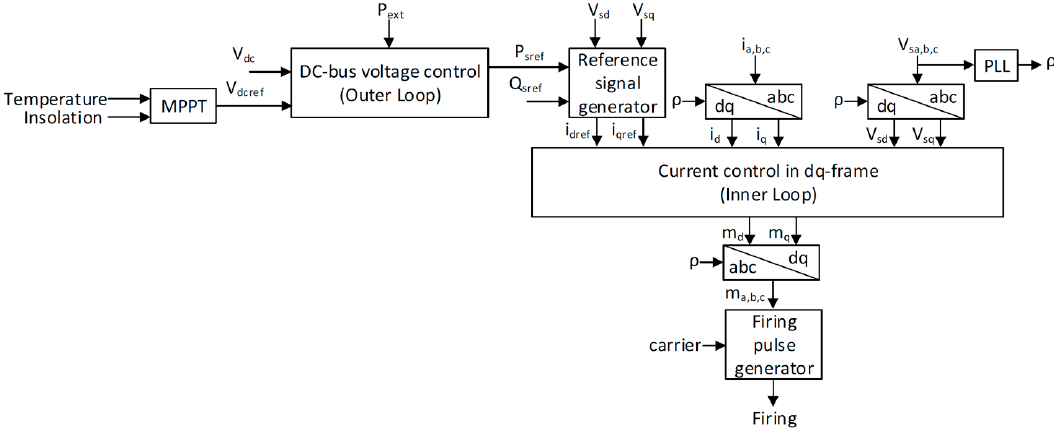
Figure 6. Components for solar PV system used in the variation model.